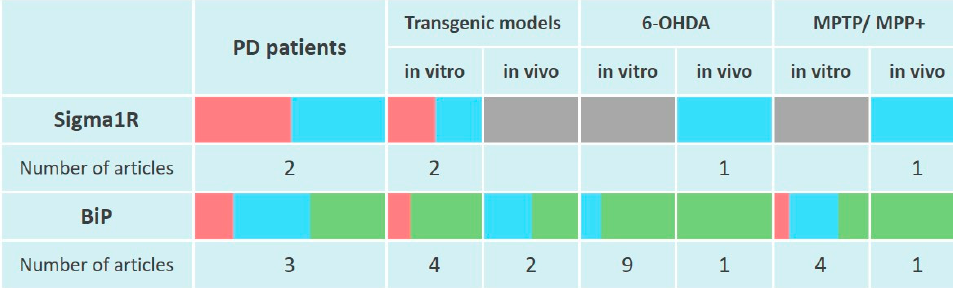
Figure 2. Changes in Sigma1R and BiP chaperones expression in the pathogenesis of Parkinson’s disease. The table reflects experimentally recorded changes in the expression of Sigma1R and BiP chaperones, denoted in relative units, according to Sections 4.1 and 4.2. PET data were used to visualize Sigma1R content in the brains of PD patients. To visualize mRNA or protein levels following markers were used: green—content increased, blue—content did not change, red—content decreased, grey—not enough data.